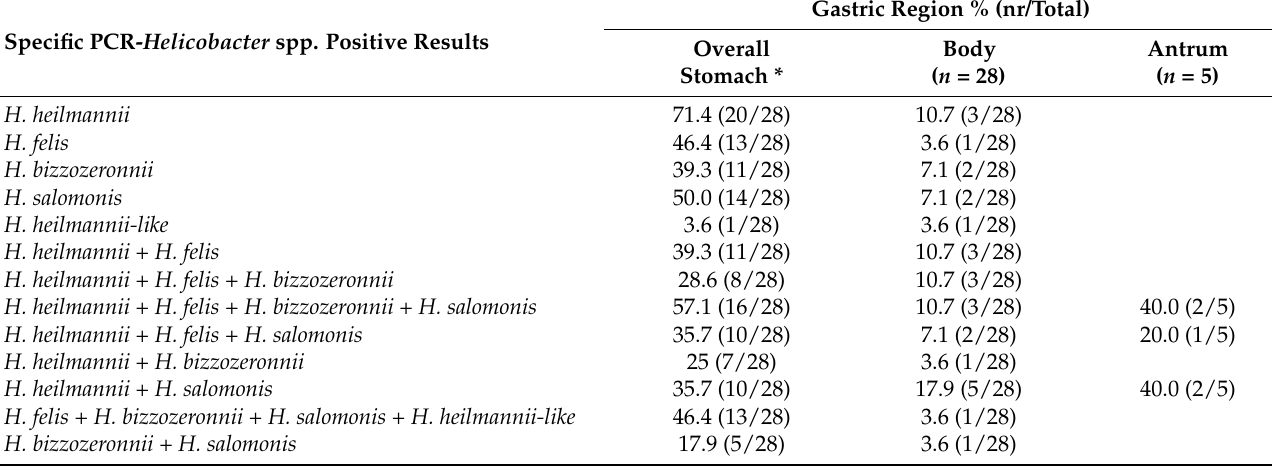
Table 4. Specific Helicobacter species detected by PCR in different compartments of the feline stomach.